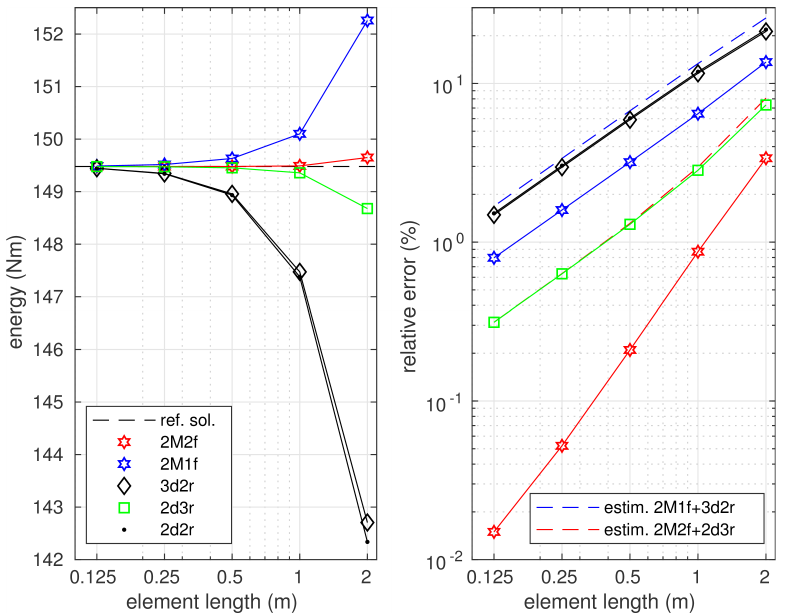
Figure 13. The strain energy and the errors of the approximate solutions in relations with the element length; K s = 1.0714 · 10 9